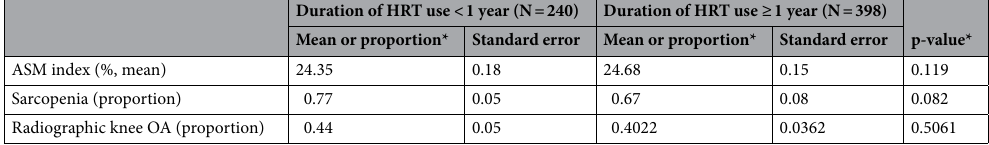
Table 5. ASM index, prevalence of sarcopenia, radiographic knee OA of the women with history of HRT use (adjusted for age and BMI). Radiographic knee OA, Kellgren-Lawrence grade scale grade ≥ 2. Continuous variables were analyzed by one-way ANOVA and categorical variables were analyzed by Rao-Scott Chi-square test. OA osteoarthritis, ASM appendicular skeletal muscle mass, Wt body weight, HRT hormone replacement therapy. *Adjusted mean or proportion and p-value were adjusted for age and